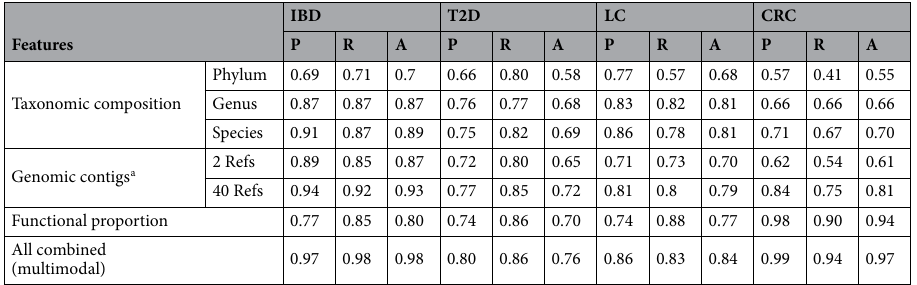
Table 2. The performance of four different model architectures. a For each experiment, LOOCV was used to calculate the precision, recall, and accuracy. Five simulation runs were performed, and the values were averaged over five runs. P precision, R recall, A accuracy.